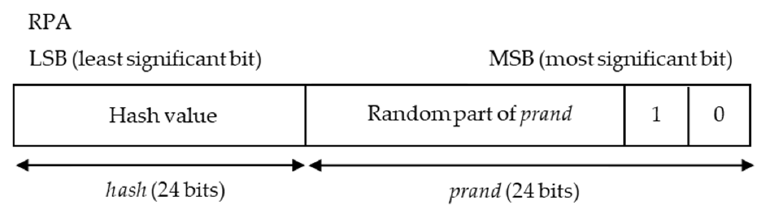
Figure 6. Format of RPA.